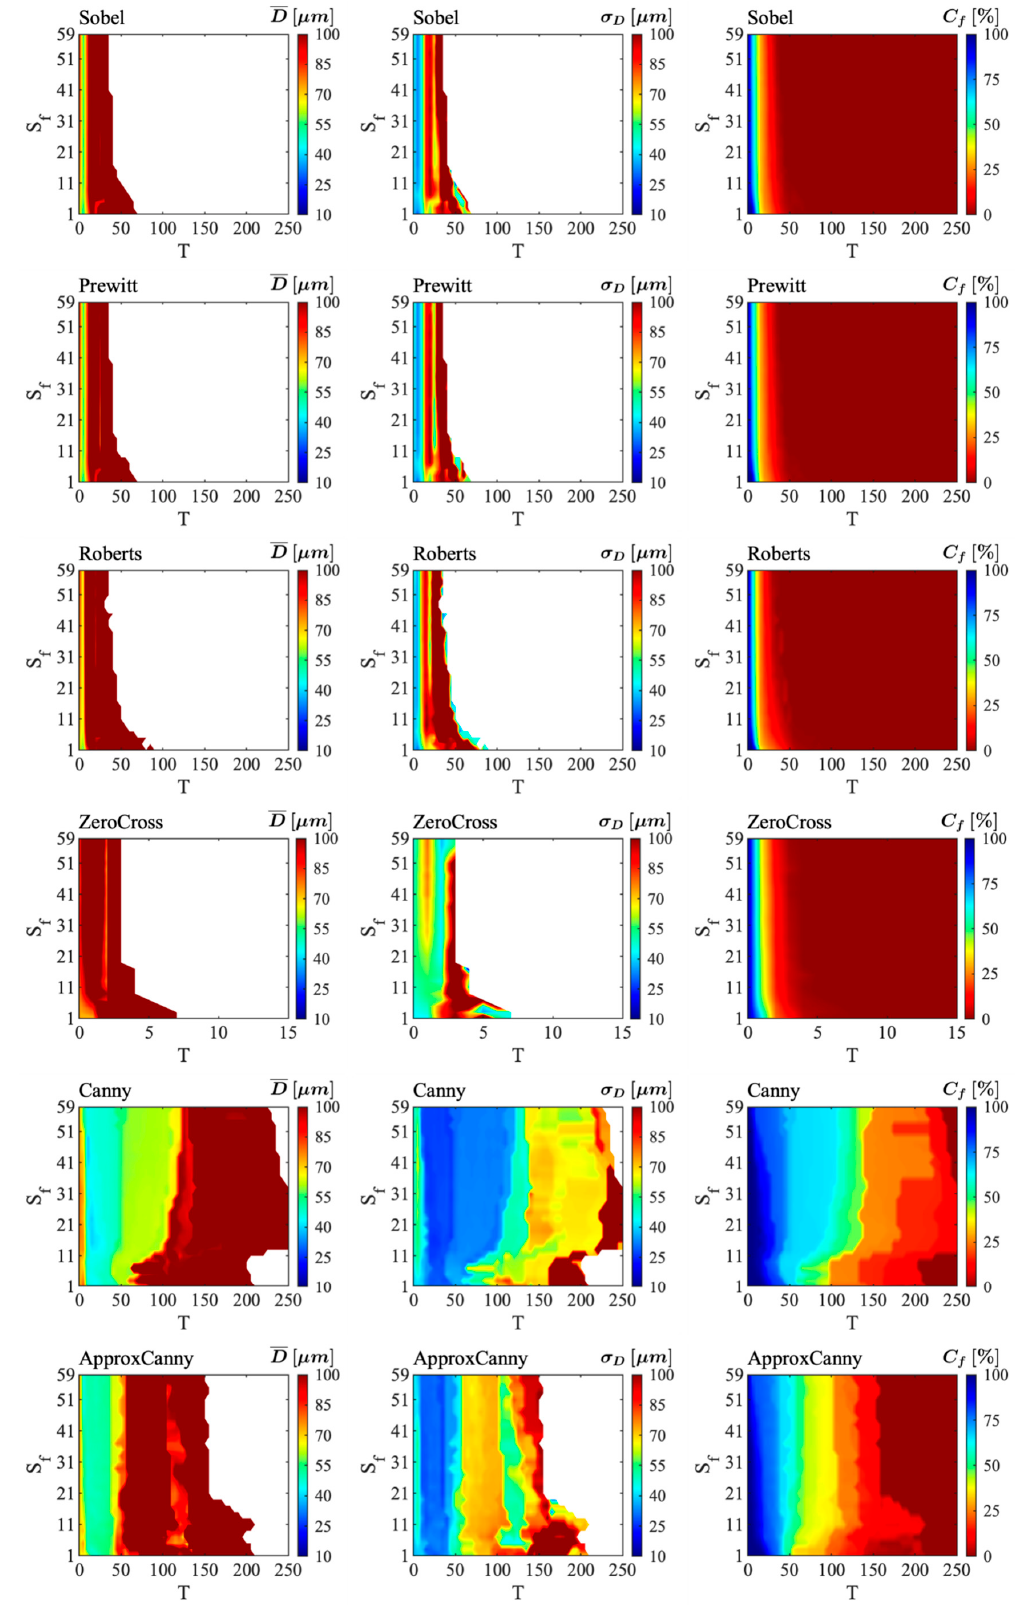
Figure 14. MQI results as a function of 𝑆 (cid:3033) and 𝑇 for every 𝑀 calculated for 𝑆𝑂3 .